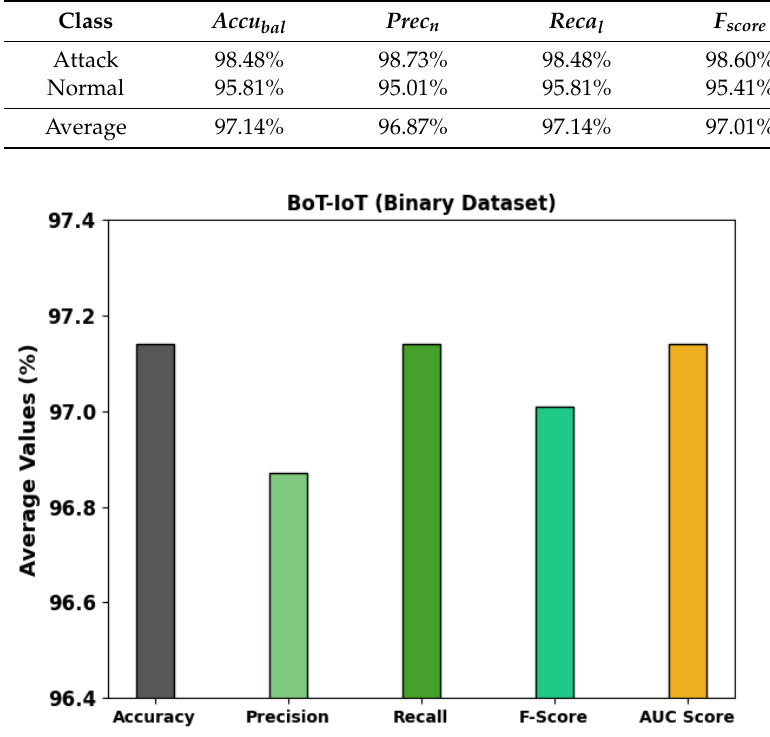
Table 3. Classification results of the H3SC-DLIDS approach on a binary dataset.